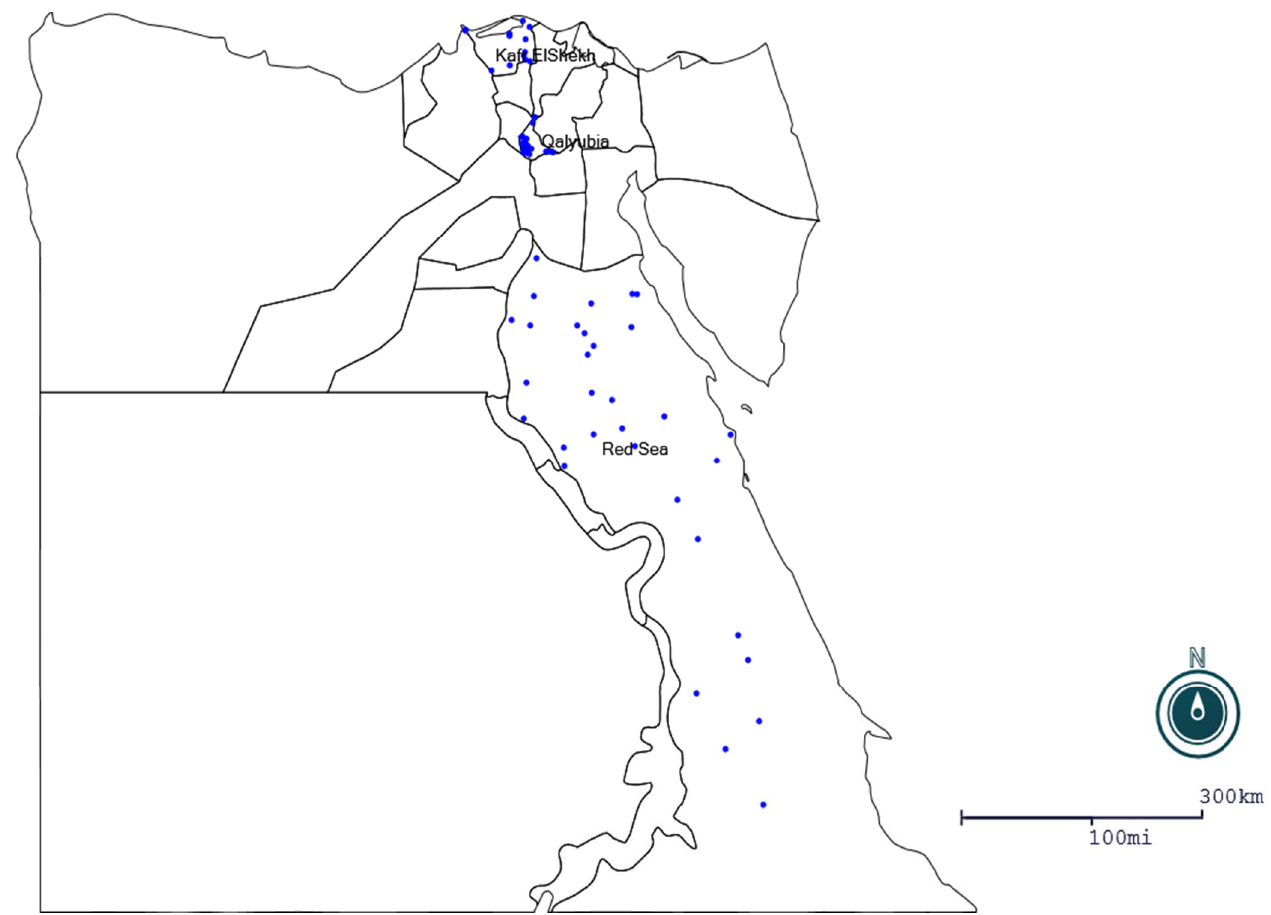
Figure 1. Geographical areas that were visited in the study and number of positive samples represented by blue dots. MAP generated by EPI MAP (CDC).